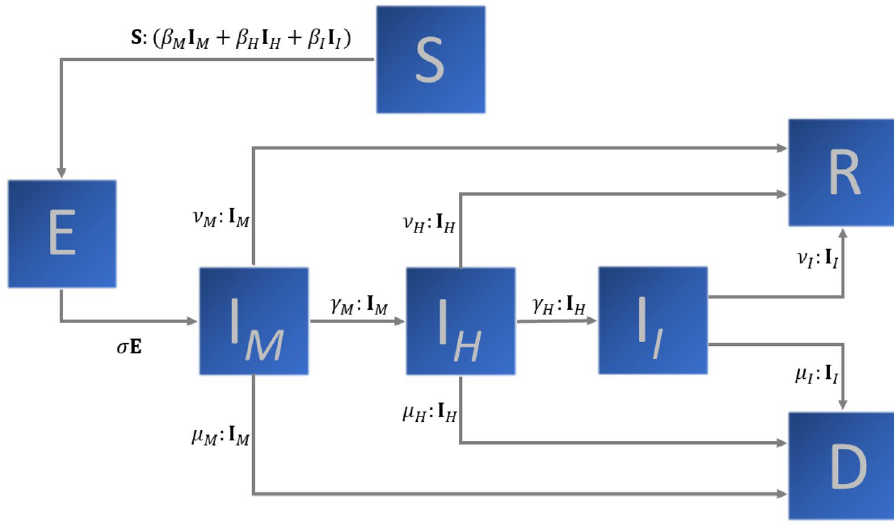
Figure 1. Schematic representation of the epidemiological model described by Eqs.